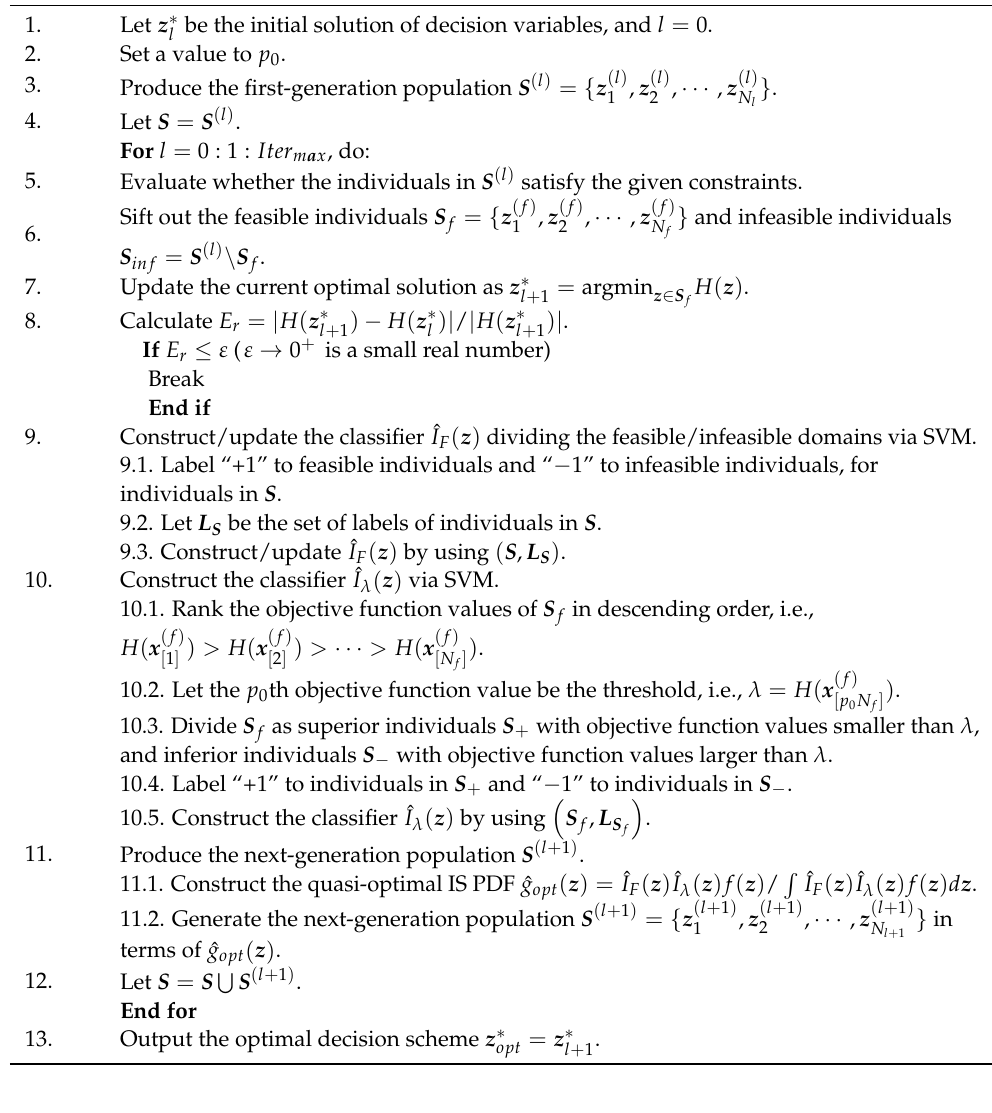
Algorithm 4 The general process of the proposed optimization